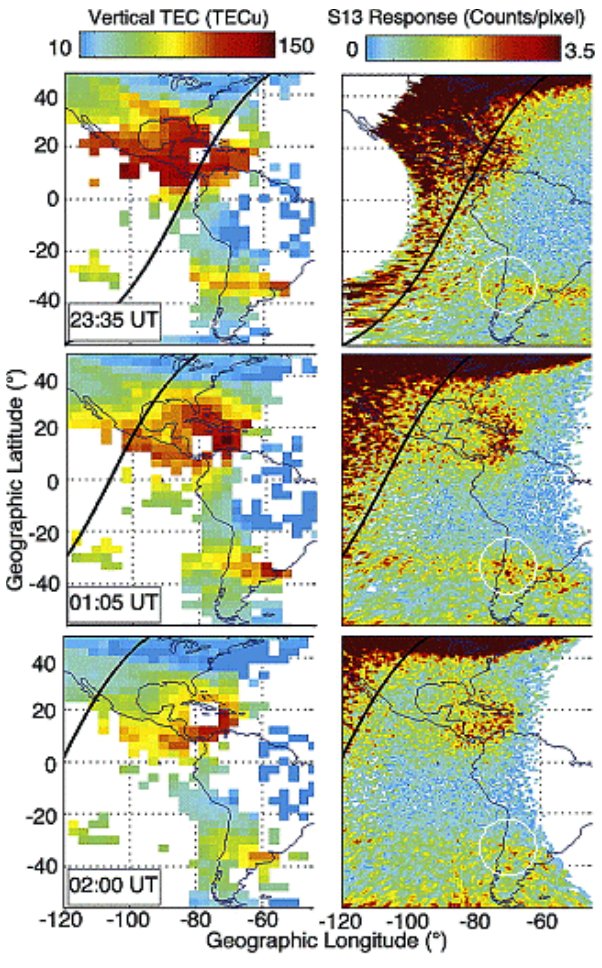
Fig. 7. GPS TEC (left panel) and IMAGE FUV (right panel) mea- surements during the large geomagnetic storm of 29–30 May 2003. White circles in the right panel represent the FOV of the all-sky camera at El Leoncito (adapted from Immel et al.,